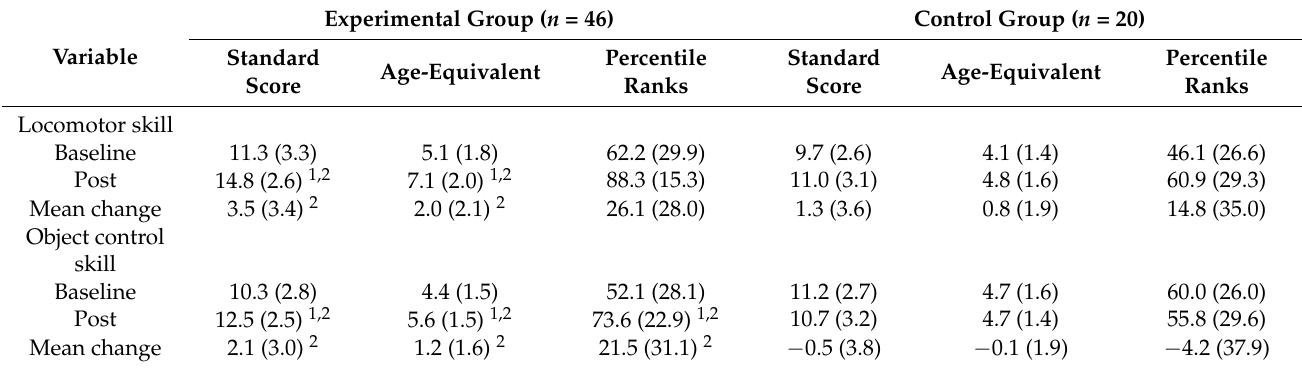
Table 2. Test of Gross Motor Development (TGMD-2) locomotor and object control scores in experimental ( n = 46) and control ( n = 20)